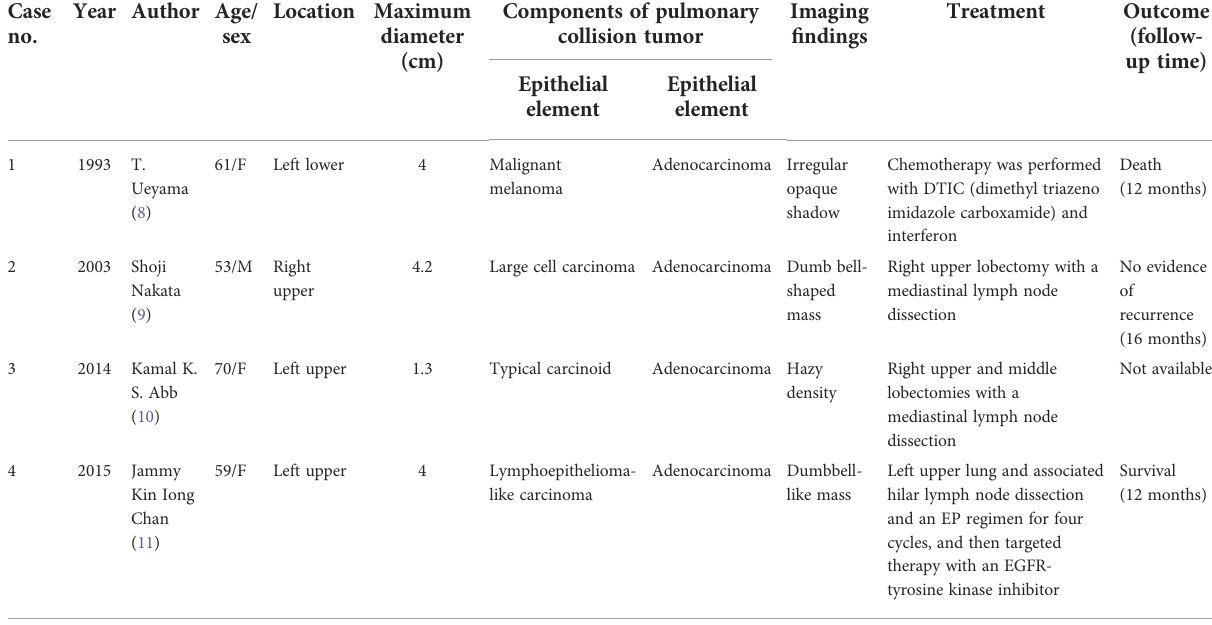
TABLE 1 Summary of published pulmonary collision tumors comprising two different epithelial elements found in the literature. Case